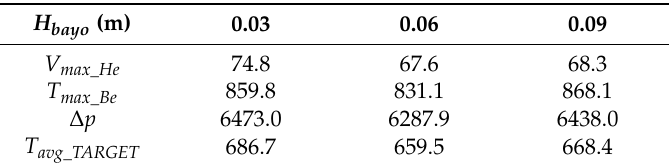
Table 7. Comparison for H bayo equal to 0.03, 0.06 and 0.09 m.